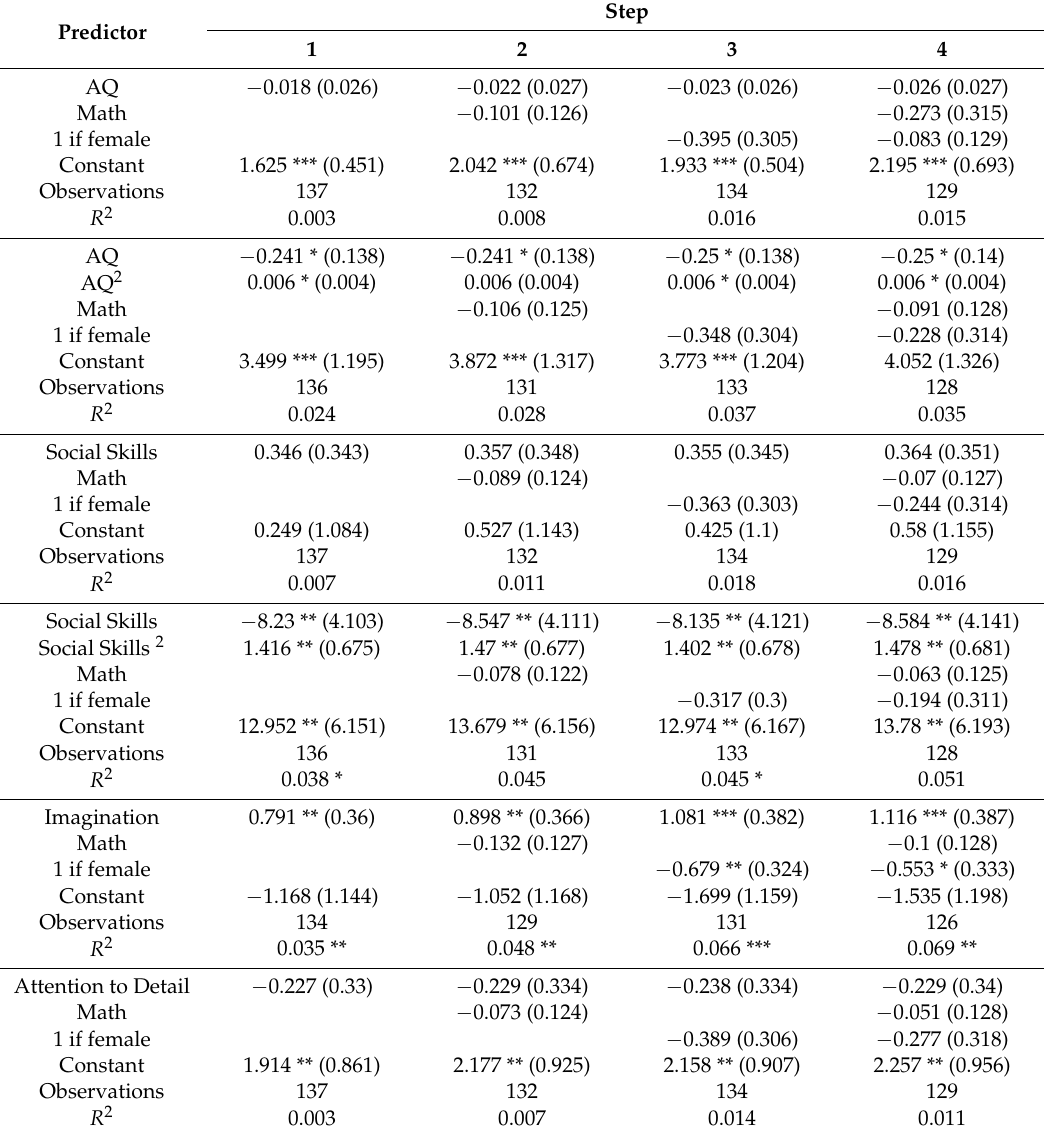
Table 2. Estimates of individual regressions models predicting depth of reasoning controlling for math skill and